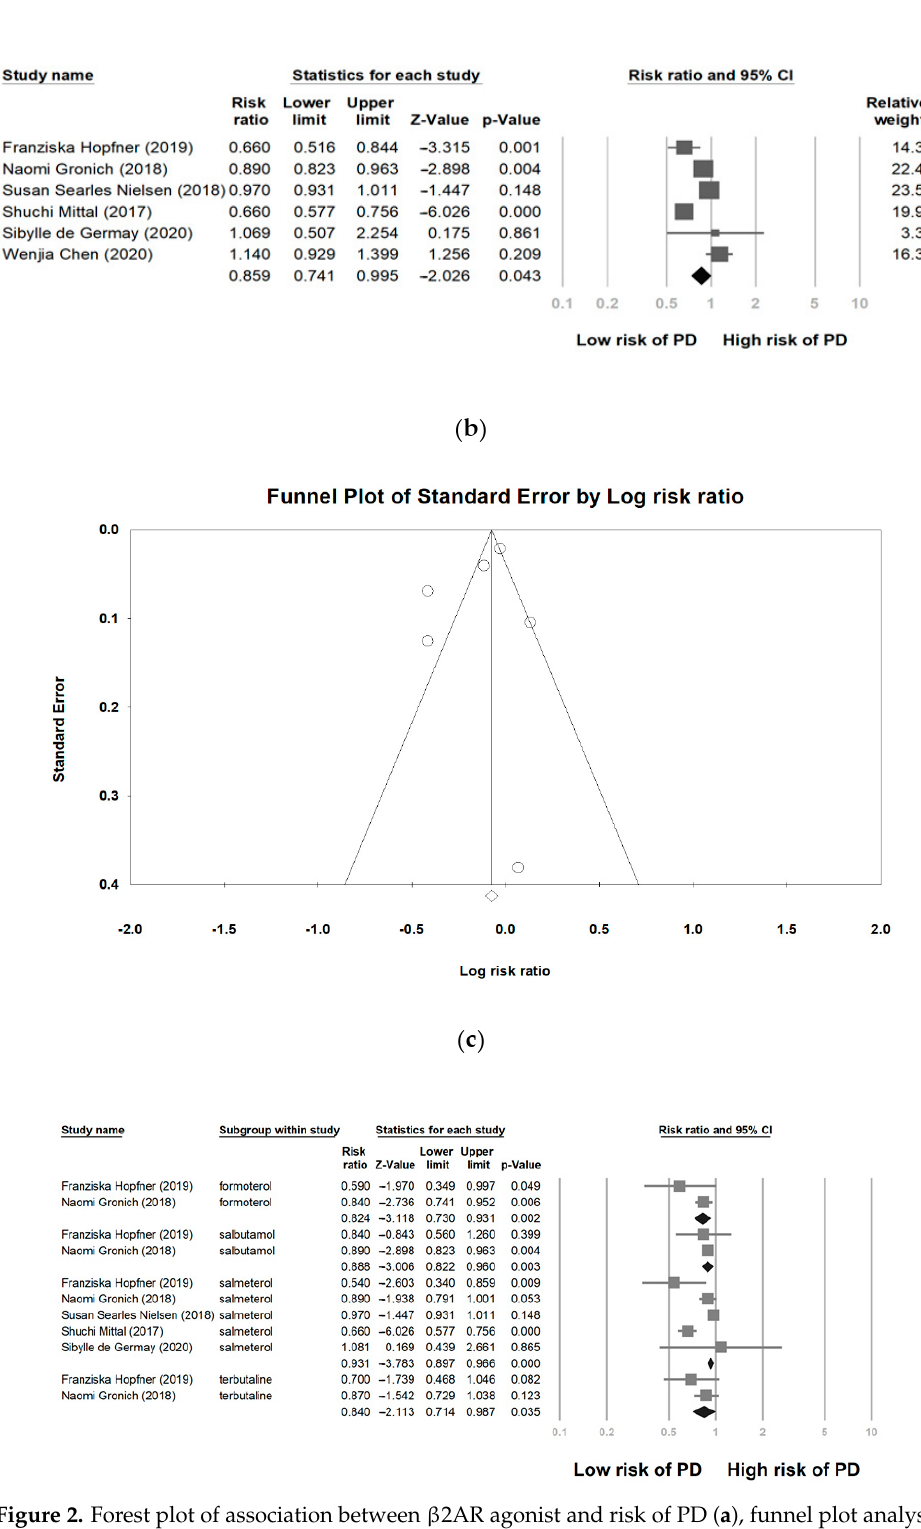
Figure 2. Forest plot of association between β 2AR agonist and risk of PD ( a ), funnel plot analysis for publication bias ( b ), and subgroup analysis of different kinds of β 2AR agonists and PD risk ( c ), PD: Parkinson’s disease, β 2AR: β 2-adrenoceptors.